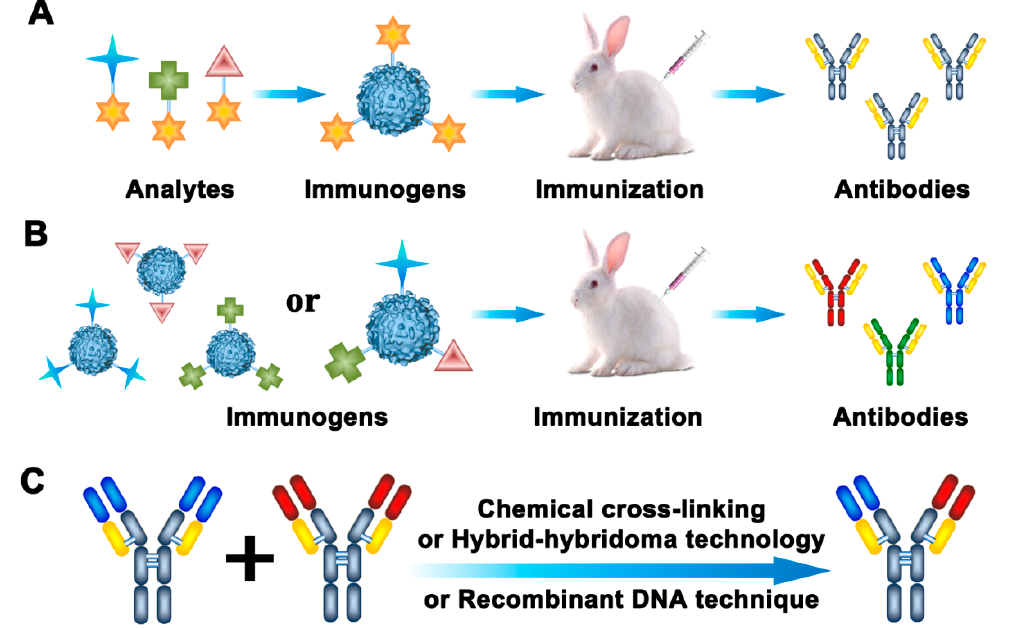
Figure 2. Generation strategies for broad specific antibodies. ( A ) Generic antibodies; ( B ) broad-spectrum antibodies; ( C ) bispecific antibodies.